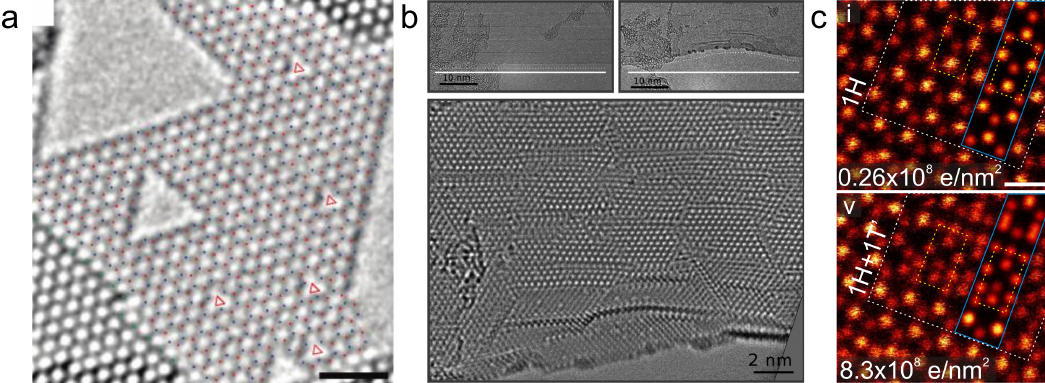
Figure 5. Electron-irradiation effects in non-graphene 2D materials. ( a ) Triangular vacancies formed into hexagonal boron nitride under electron irradiation at 80 kV. The red and blue marks stand for atoms of the two different elements. The scale bar is 1 nm. Reprinted with permission from Ref. [66], Copyright (2009) American Chemical Society. ( b ) Accumulation of defects close to an edge of MoS 2 under 80 kV electron irradiation. In the last frame (bottom), the created vacancies have arranged into line-defects oriented with respect to the edge. Reprinted with permission from Ref. [68], Copyright (2013) American Physical Society. ( c ) Phase transition 1H → 1T’ in MoTe 2 caused by electron irradiation at 60 kV. Scale bar is 0.5 nm. From Ref. [70],